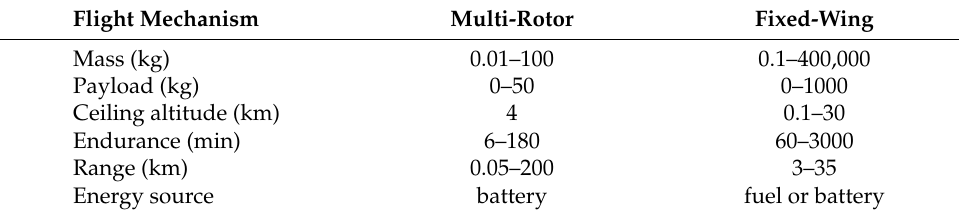
Table 4. Differences between fixed wing and multi-rotor UAVs, after